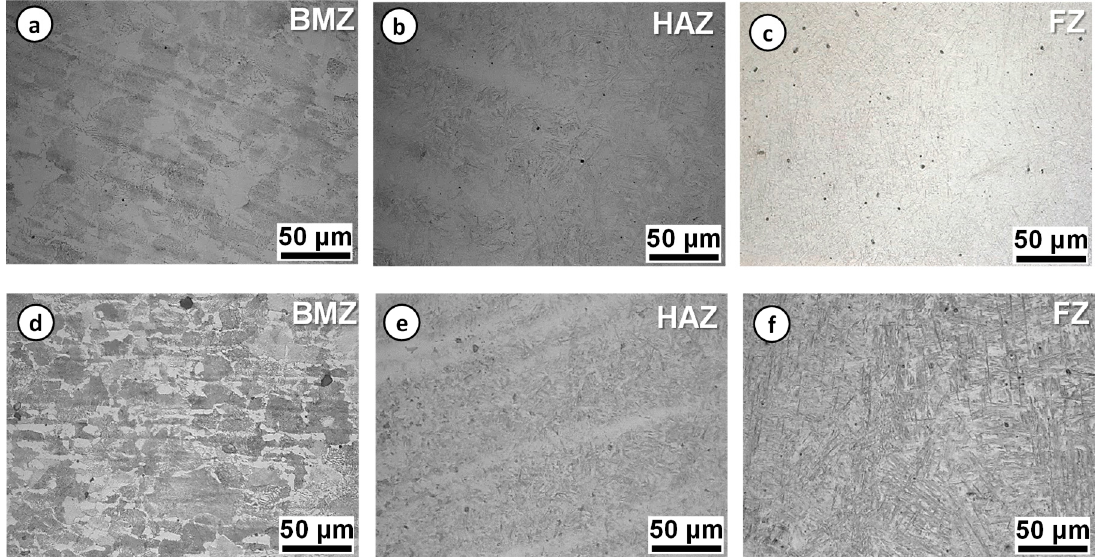
Figure 10. Microstructures of laser-arc hybrid weld joints: ( a – c ) Type-I and ( d – f ) Type-II.